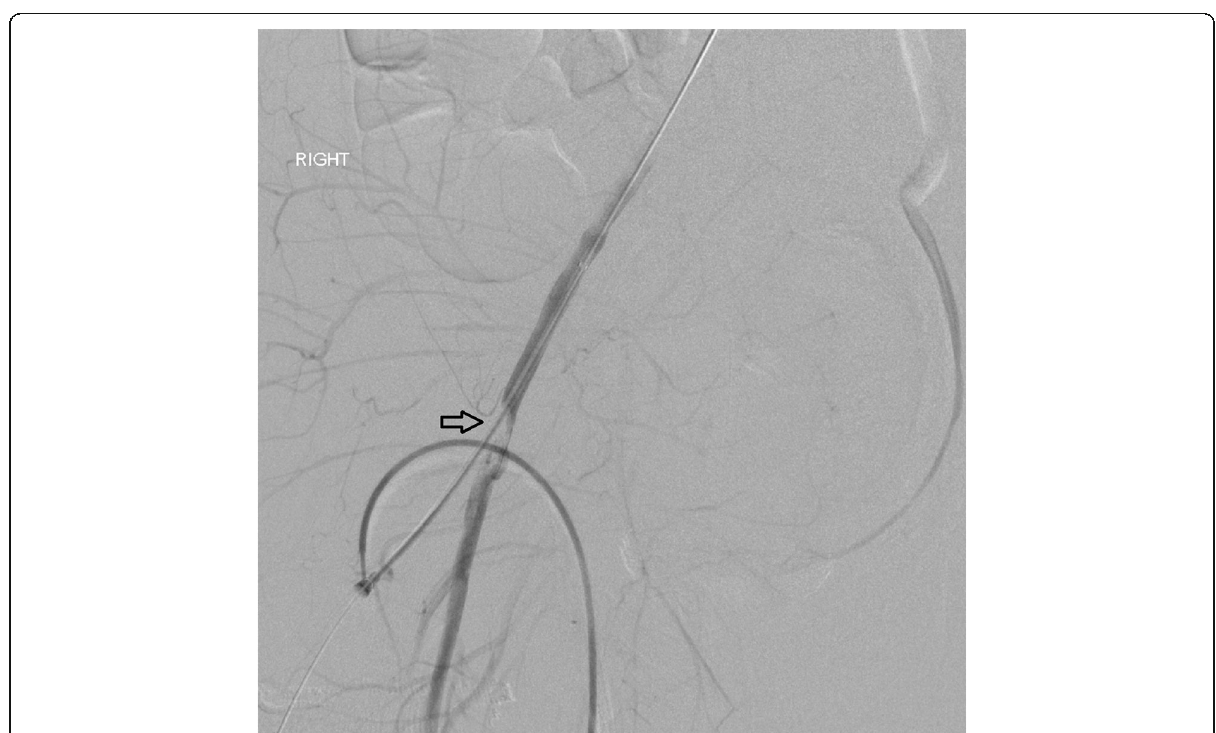
Fig. 1 23 year old female with PPH not controlled with Bakhri balloon compression and TXA who presented for uterine artery embolization. Angiogram post embolization showed thrombus in the right common femoral artery at the site of arterial access